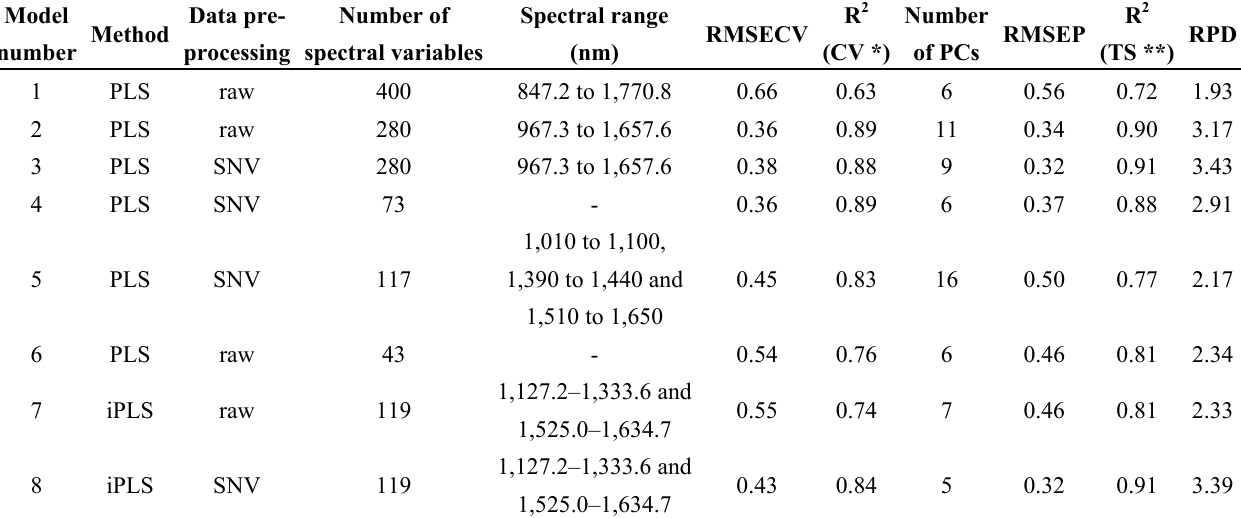
Table 1. Validation statistics.